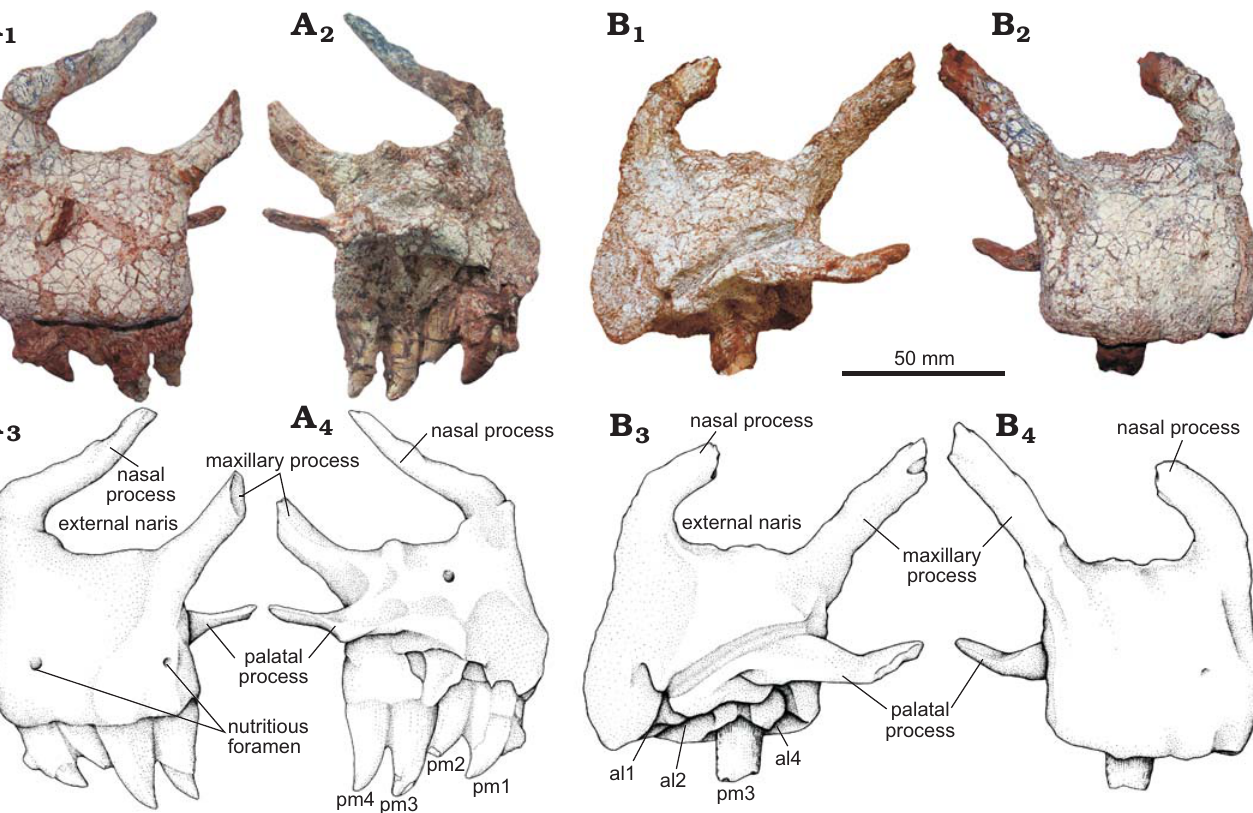
Fig. 4. The pseudosuchian archosaur Prestosuchus chiniquensis Huene, 1938 (UFRGS-PV-0629-T) from the Dinodontosaurus Assemblage Zone, Ladinian, Middle Triassic, Dona Francisca municipality, Rio Grande do Sul State, Brazil. A . Left premaxilla in lateral (A 1 , A 3 ) and medial (A 2 , A 4 ) views. B . Right premaxilla in medial (B 1 , B 3 ) and lateral (B 2 , B 4 ) views. pm3, pm4, refer to premaxillary tooth position; al1, al2, al4, refer to premaxillary empty alveoli position. Photographs (A 1 , A 2 , B 1 , B 2 ) and explanatory drawings (A 3 , A 4 , B 3 , B 4